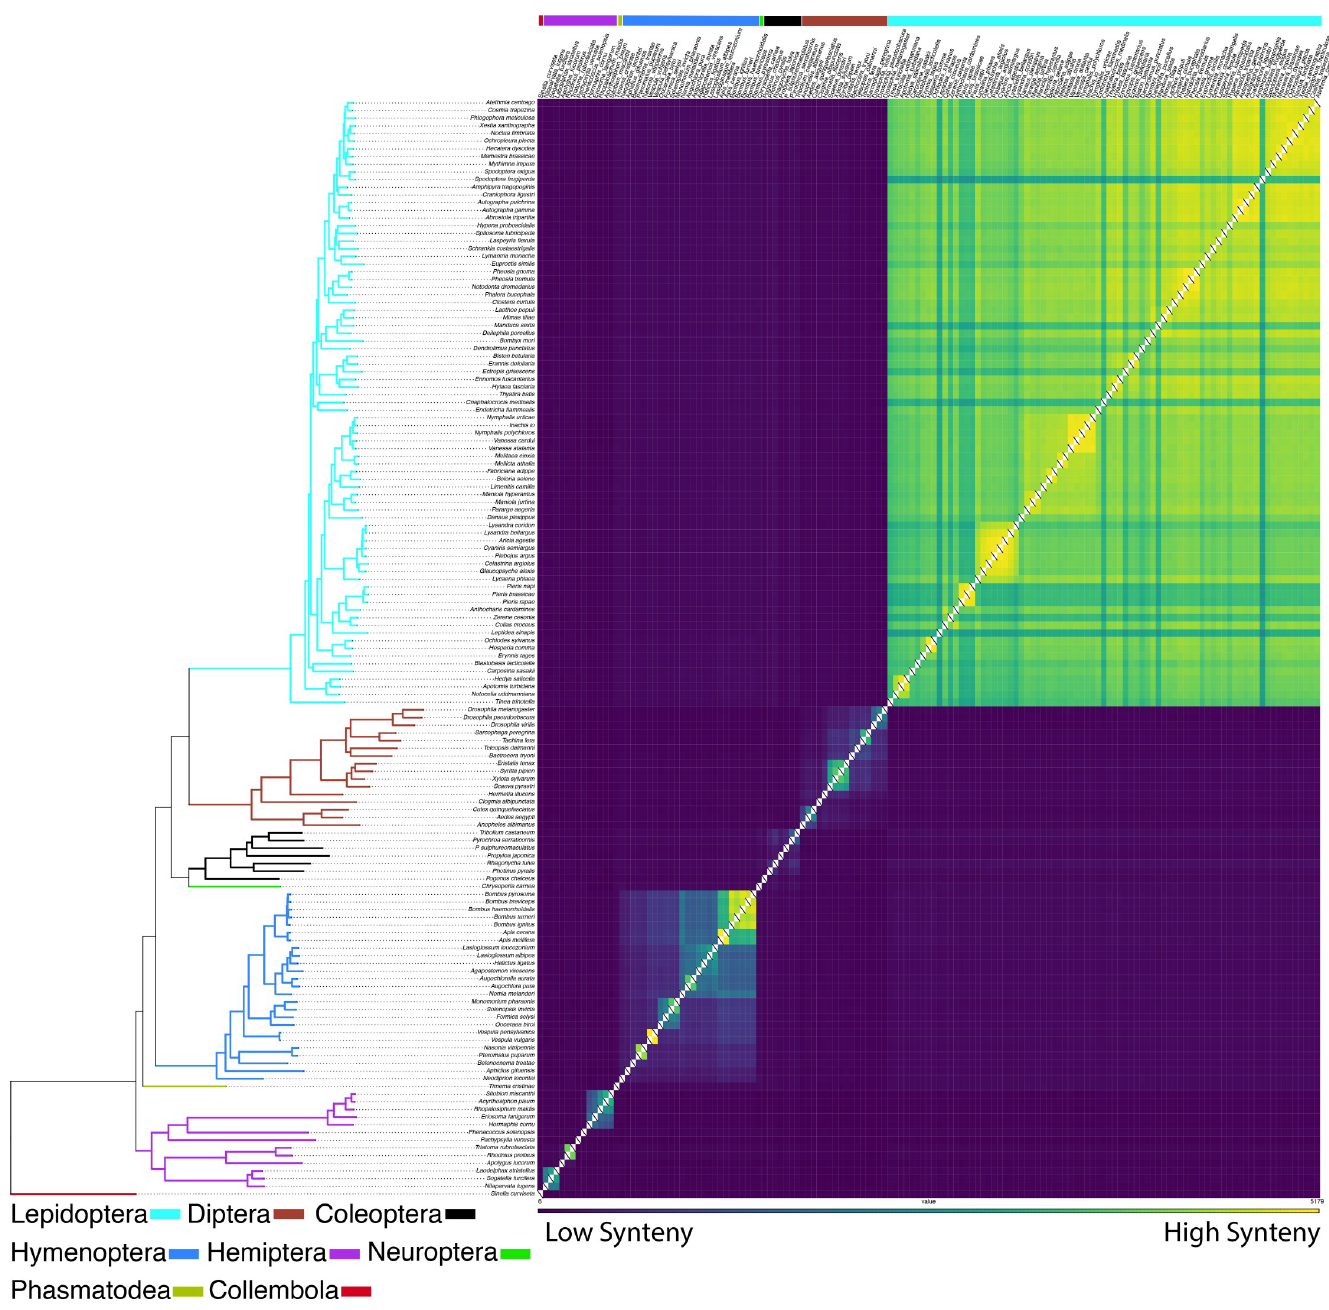
Fig 7. Insecta, gene order conservation score (GOC) of BUSCO genes. Left, phylogeny of taxa in analyses, derived from BUSCO genes (610,189 AA sites), reconstructed via RAxML-ng, branches colored by insect order. Right, heat map from pairwise comparisons among insects with chromosome level genomes (only genes localized to chromosomes considers in analyses). Comparisons of gene order which are more syntenic (higher GOC scores) appear in yellow boxes, dark purple indicate less synteny between taxa pairs. across other insect orders. A characteristic of Lepidoptera is having a high level of synteny across different families [23,30]. We find that relative to other insect orders sampled that Lepi- doptera does have a lower rate of synteny decay. Here we performed the first formal test of this